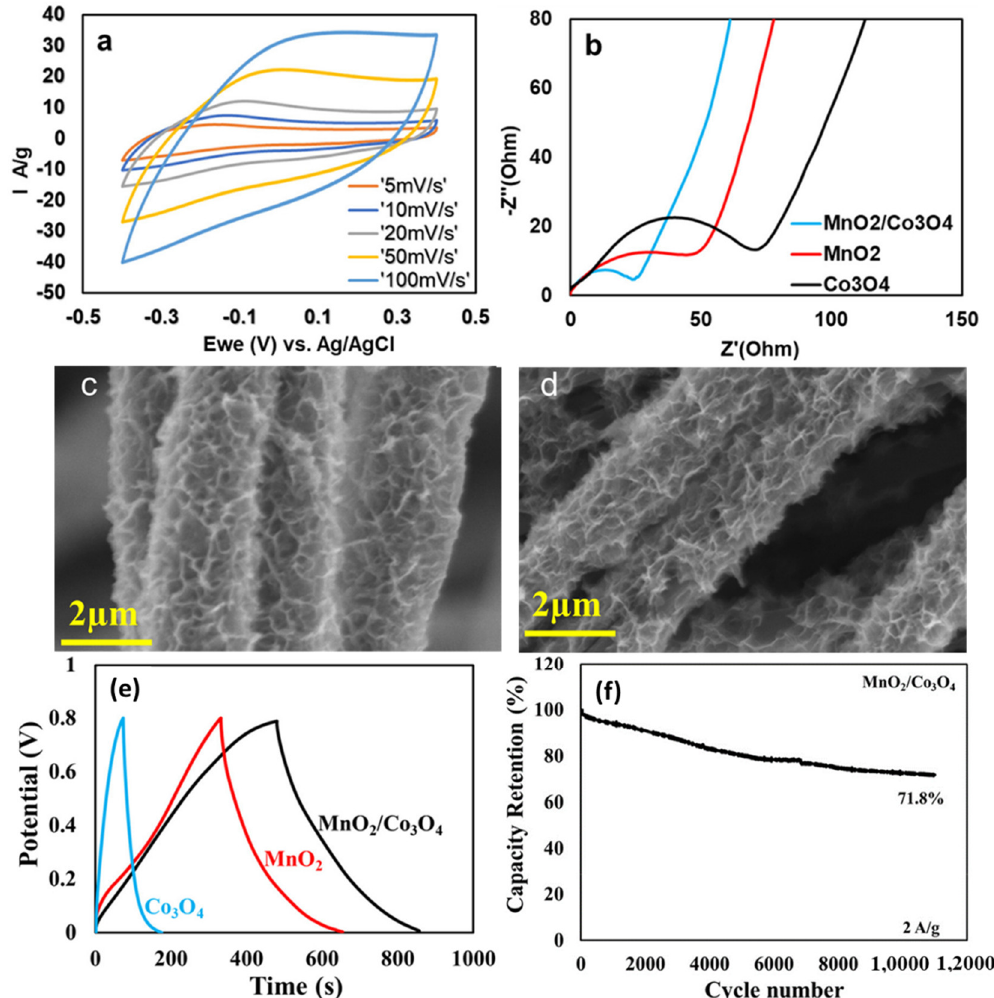
Figure 11. ( a ) The CV curves of MnO 2 /Co 3 O 4 @SA-ECNFs; ( b ) the EIS spectra of different samples; ( c ) and ( d ) the SEM micrographs before and after cycling; ( e ) the GCD profile of different samples; and ( f ) the cyclic stability of MnO 2 /Co 3 O 4 @SA-ECNFs [76], open access.